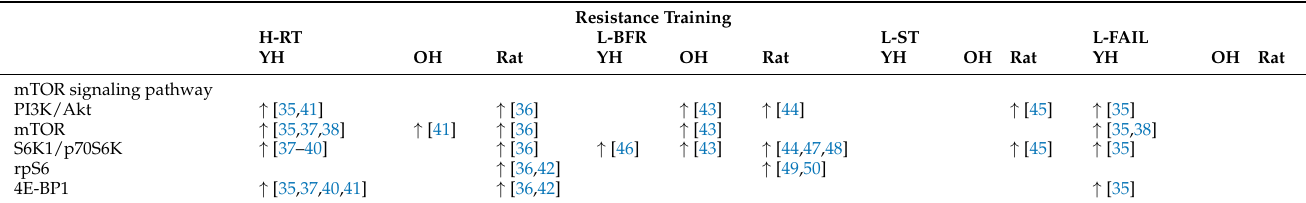
Table 2. Effects of resistance exercise/training on mTOR signaling pathway in young/older adults or rat models based on previous